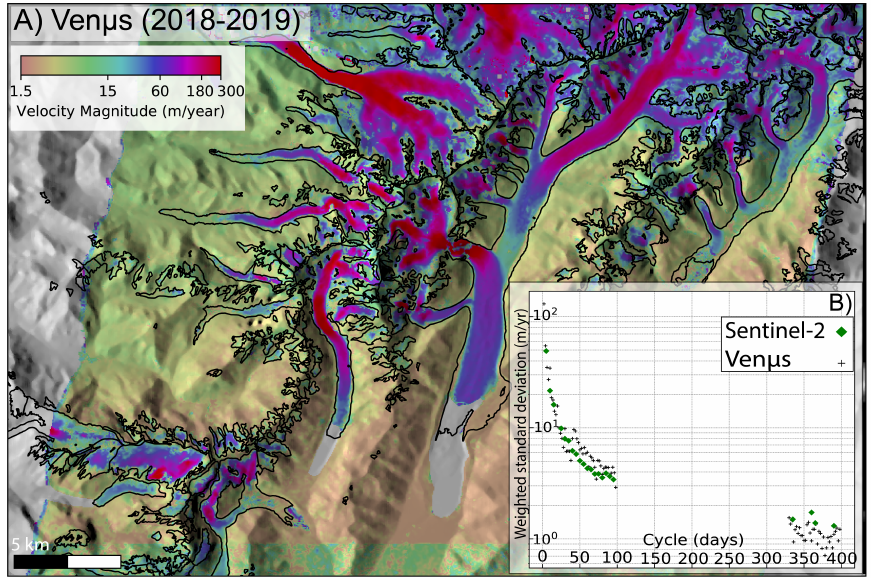
Figure 6. ( A ) Glacier surface velocity mosaic from Ven µ s images acquired in years 2018 and 2019 over the Tasman Glacier region (Southern Alps of New Zealand); ( B ) Evolution of precision on stable ground for Ven µ s (black cross) and Sentinel-2 (green diamond) with the length of the repeat